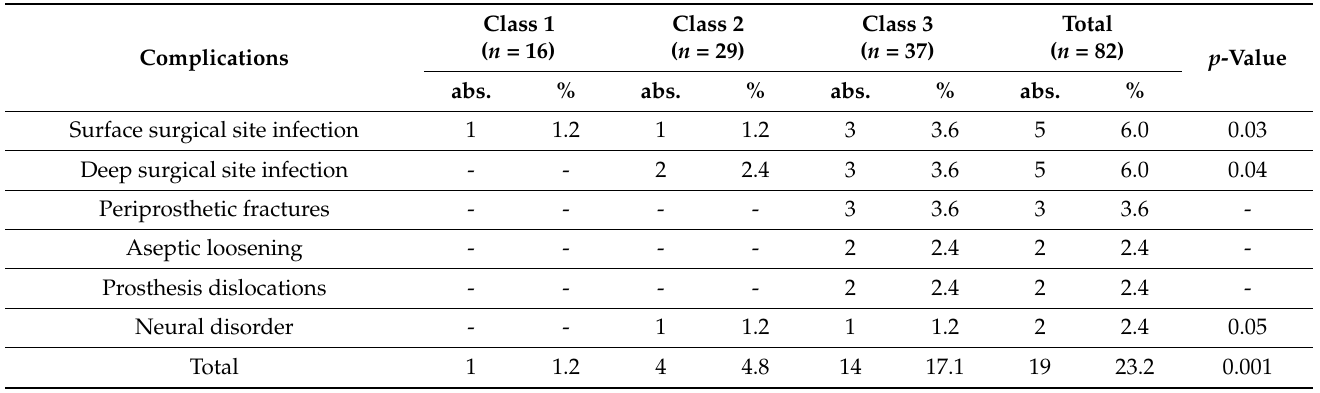
Table 4. Stage 2 of the study—complications